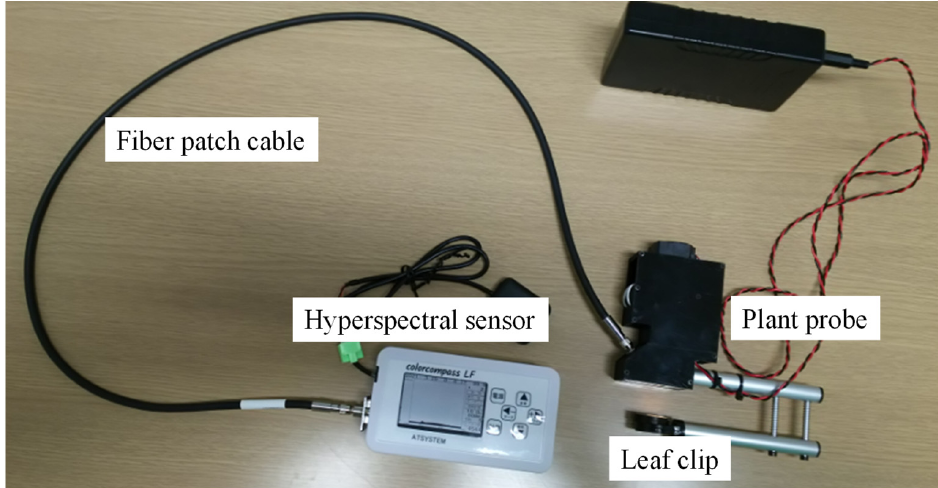
Figure 3. The compact spectrometer and plant probe with a leaf clip used in this study.